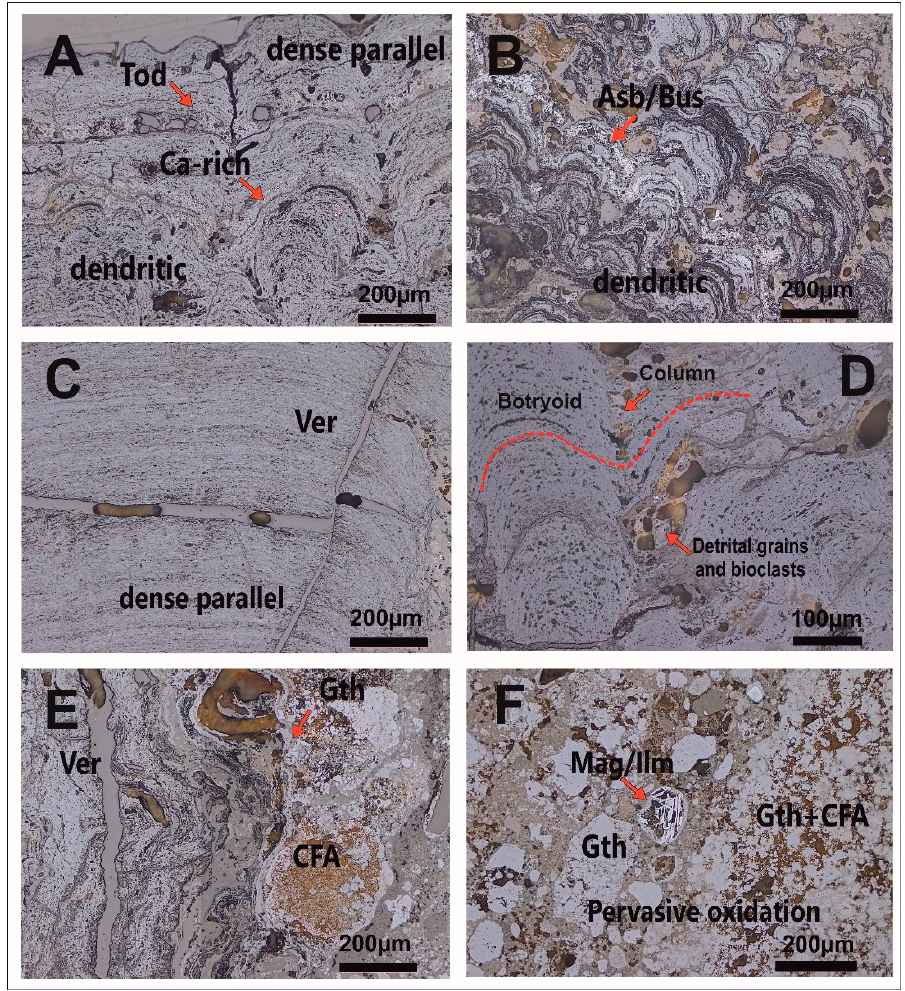
Figure 3. Microphotographs of the studied thin sections. ( A ) DR02-10, variation from dendritic to dense parallel textures and the presence of bright laminae of todorokite (Tod); ( B ) DR07-9, dendritic structure crowned by several bright laminae with fibrous minerals of asbolane (Asb) and buserite (Bus); ( C , D ) DR16-14, dense parallel and columnar textures essentially composed by vernadite (Ver); ( E ) 107-11H, contact between altered substrate (right) and Fe-Mn crust (left) with the presence of goethite (Gth) and carbonate-fluorapatite (CFA); ( F ) 107-11H, pervasive oxidation and phosphatization of the substrate rock with residual magnetite/ilmenite (Mag/Ilm) crystals. XRD analyses on bulk samples show their low crystallinity, low counts and un-defined reflections of these ferromanganese mineralizations. Detected minerals are predominantly represented by Mn-oxides and Fe-oxyhydroxides with low contents of detrital minerals. Fe-vernadite